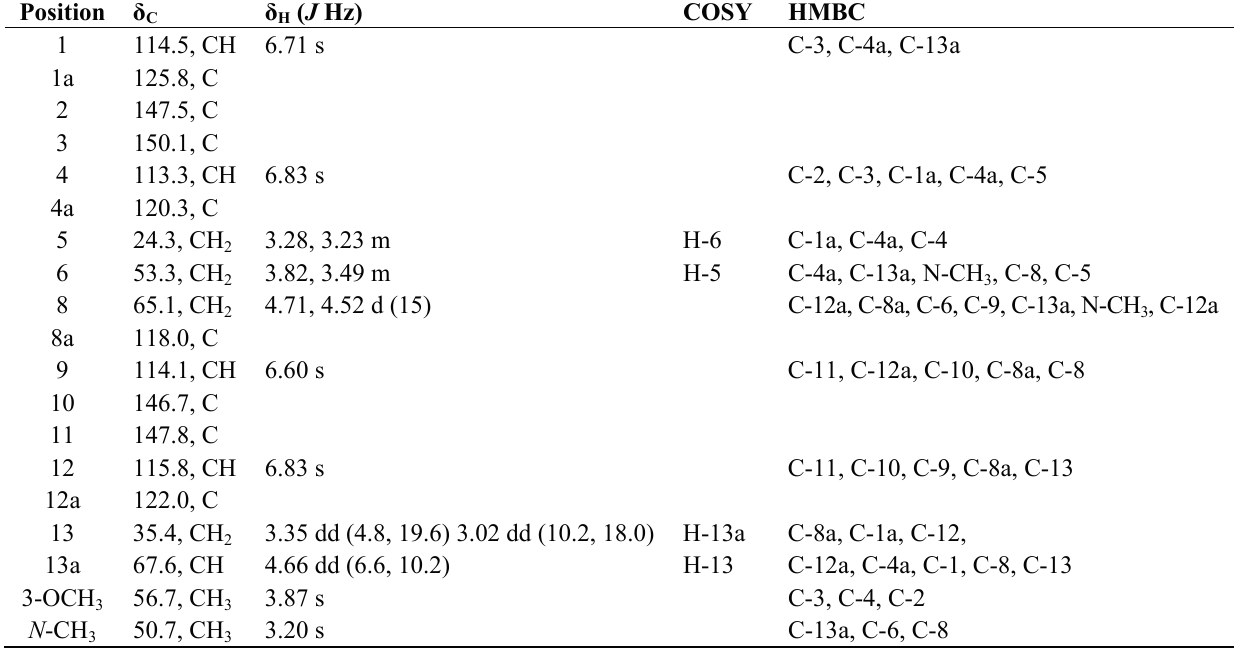
Table 1. 1 H- (600 MHz, δ ppm, J in Hz), 13 C-NMR (150 MHz, δ ppm), COSY and HMBC spectroscopic data for compound 1 in methanol- d